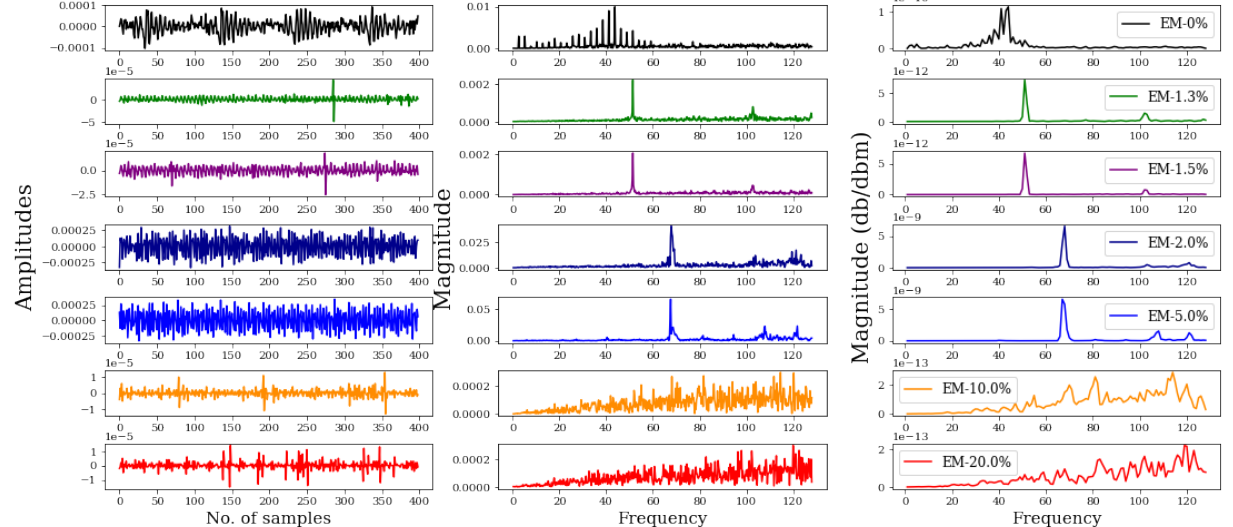
Figure A9. CR differentials and their FFT and PSD outputs at 1700 RPM for the emulsion compositions.